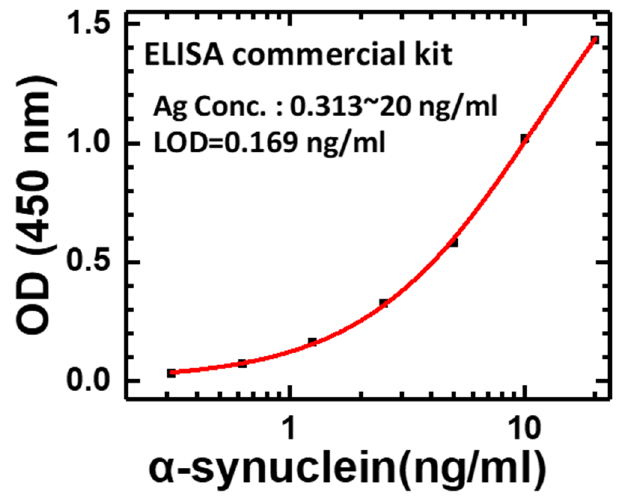
Figure 2. OD value of a calibration curve with different concentrations of α-synuclein antigen measured by conventional ELISA.